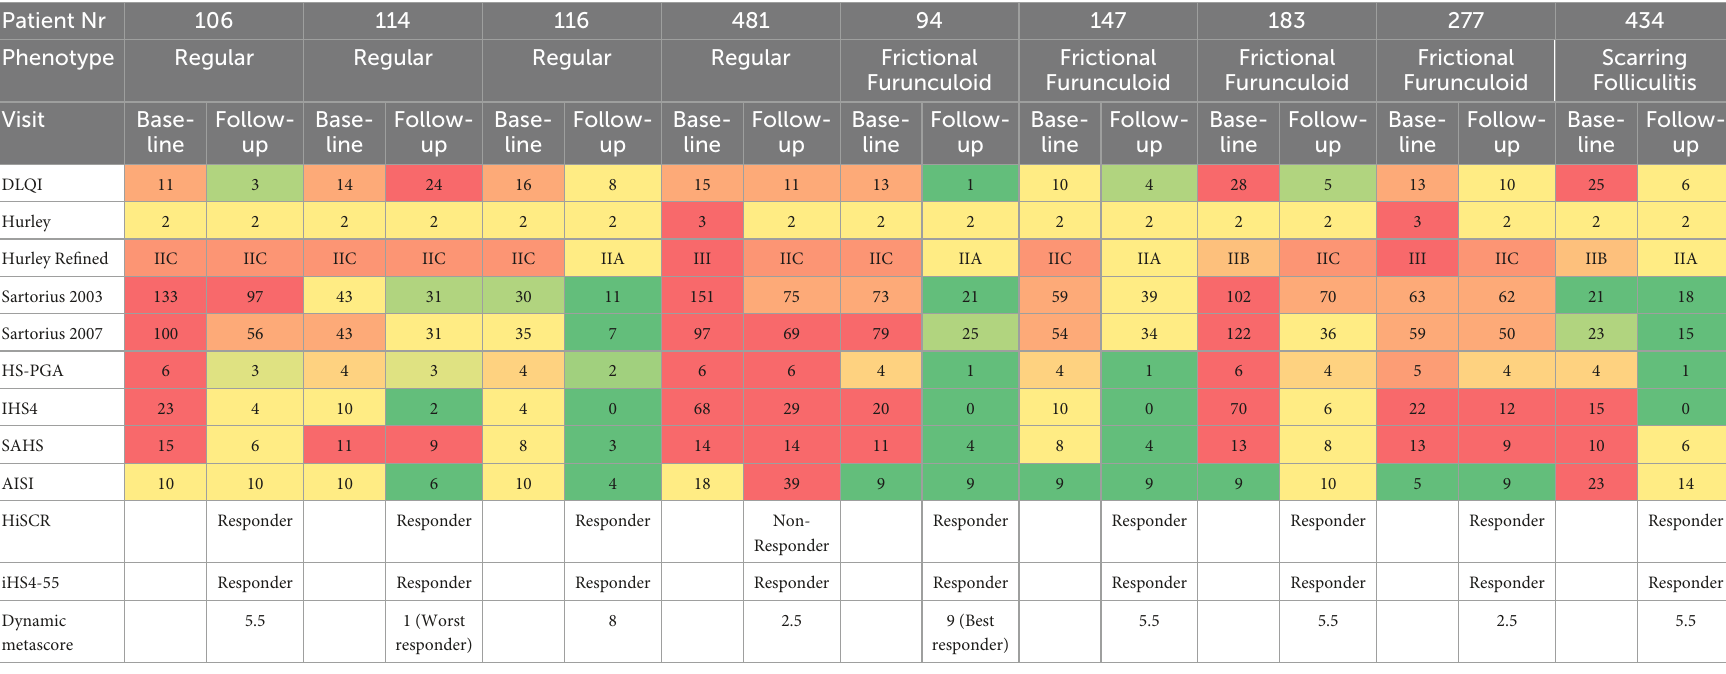
TABLE 2 Comparison of the evolution of scores after 8 to 15 weeks of